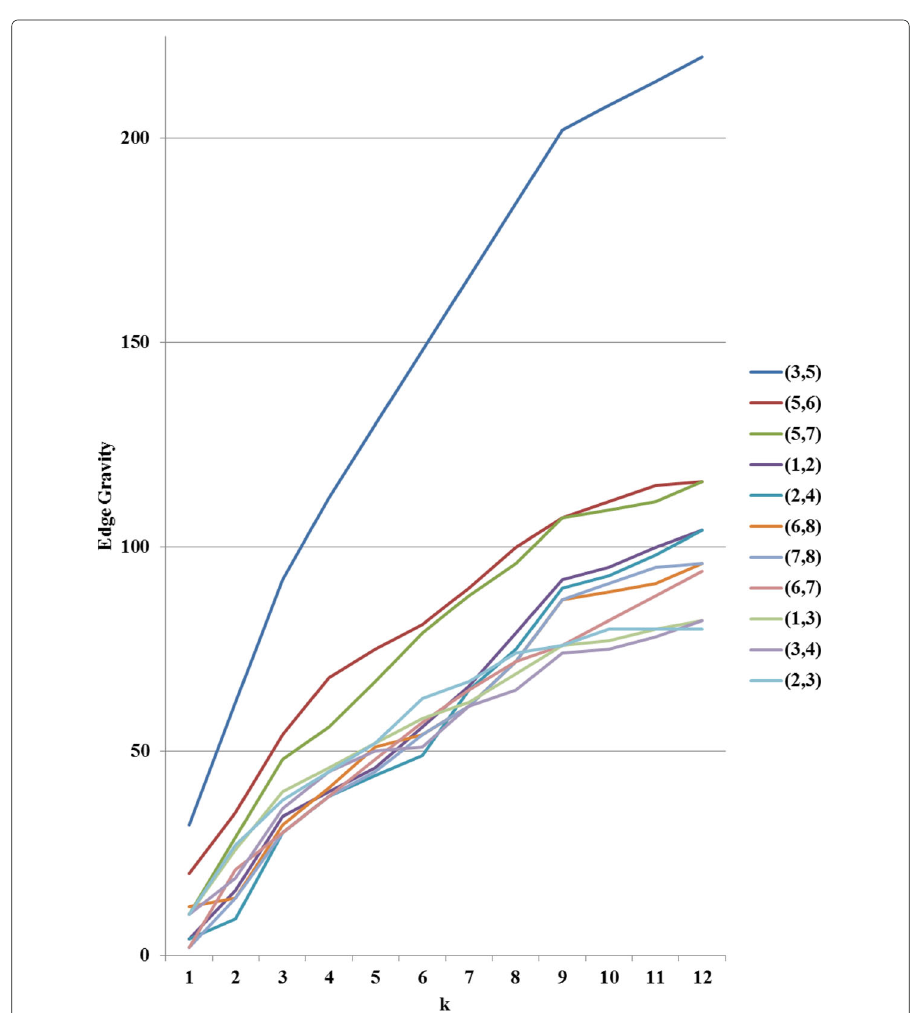
Fig. 6 Edge Gravity solutions for the example extension in Fig. 4 when solving the Edge Gravity Algorithm successively for k = 1,2,3, ... ,12. k ∗ = 12